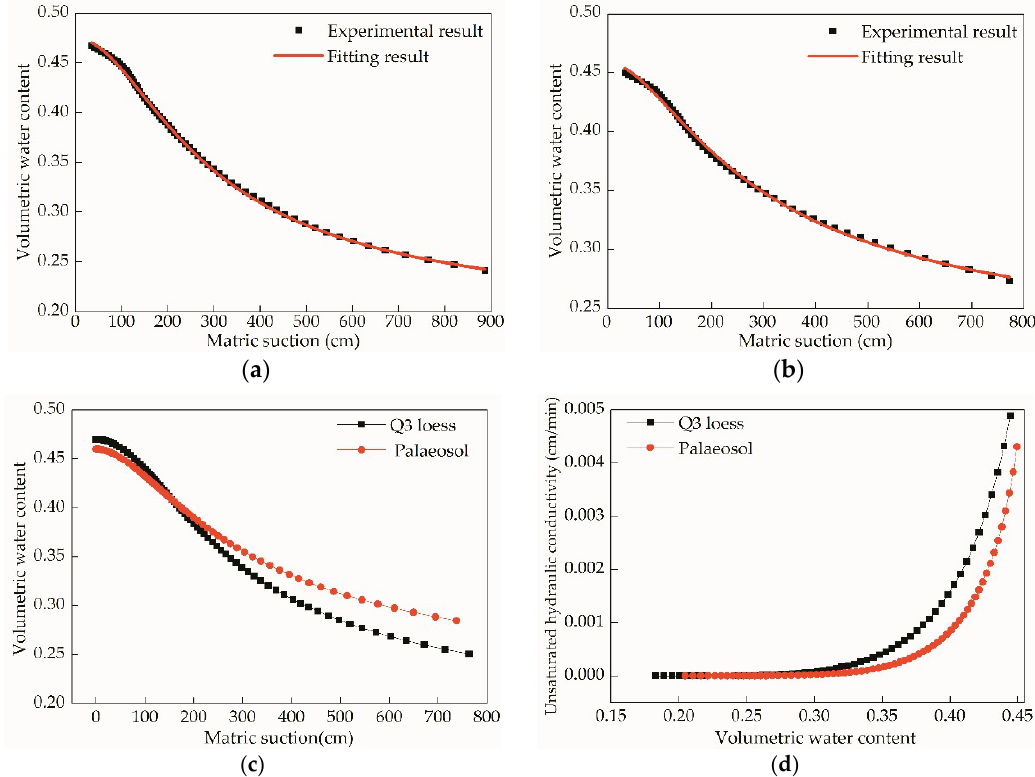
Figure 11. The basic hydraulic properties: ( a ) the fitting of the loess SWCC; ( b ) the fitting of the palaeosol SWCC; ( c ) the SWCC comparison between the two different soils; ( d ) the comparison of the hydraulic conductivity between the two different soils.